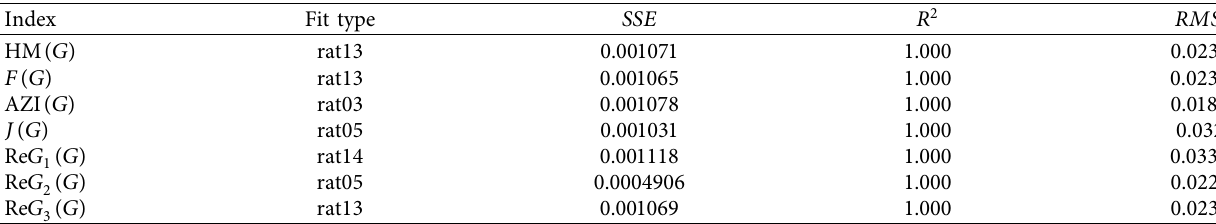
Table 8: Goodness of fit for entropy vs. indices for TbO